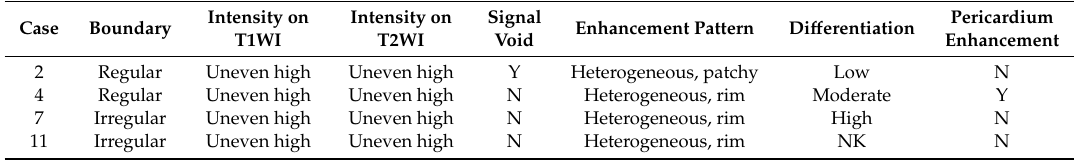
Table 3. Magnetic resonance imaging (MRI) features of primary cardiac